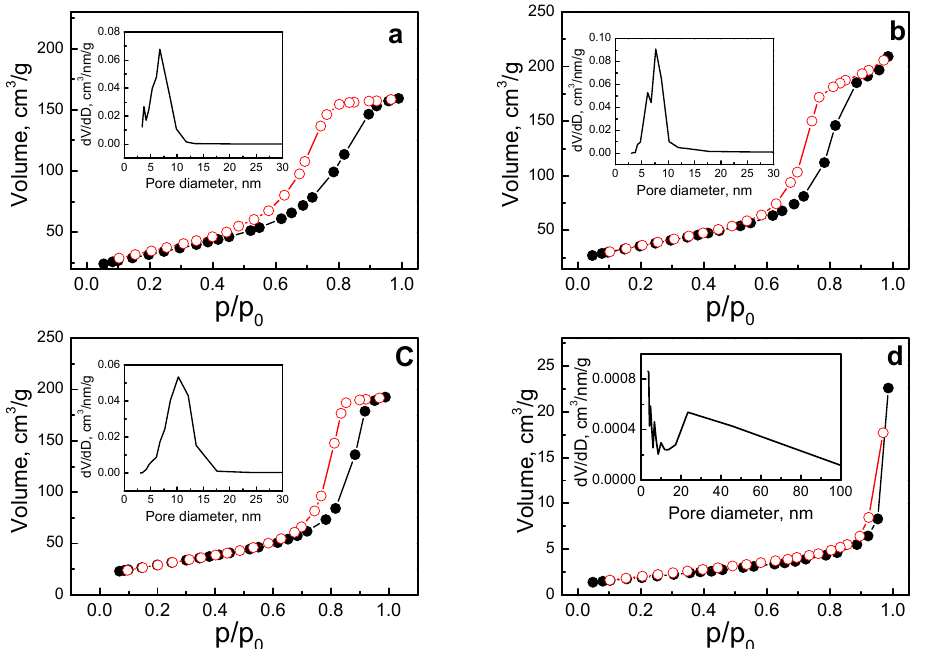
Figure 2. Adsorption–desorption isotherms of: ( a ) β -Ni 1/2 Mn 1/2 (OH) 2 ; ( b ) ilmenite NiMnO 3 ; ( c ) mixture of NiMnO 3 and Ni 1.5 Mn 1.5 O 4 ; and ( d ) LiNi 1/2 Mn 1/2 PO 4 . Filled and open symbols denote adsorption and desorption curves, respectively. The insets show the pore size distribution curves. In synchrony with the porosity, the morphology of the samples is also specific. The morphology consisted of micrometric aggregates with various shapes (Figure 3). For NiMnO 3 , spherical aggregates with sizes of around 1–5 µ m dominated, whereas for β -Ni 1/2 Mn 1/2 (OH) 2 and its oxide-derivative, unshaped aggregates with sizes larger than 10 µ m appeared. For NaNi 1/2 Mn 1/2 PO 4 , having a lower specific surface area, primary well- shaped particles inside aggregates could be distinguished, with the particle dimensions being of 0.4–0.8 µ m. For LiNi 1/2 Mn 1/2 PO 4 , spherical aggregates were mostly observed.